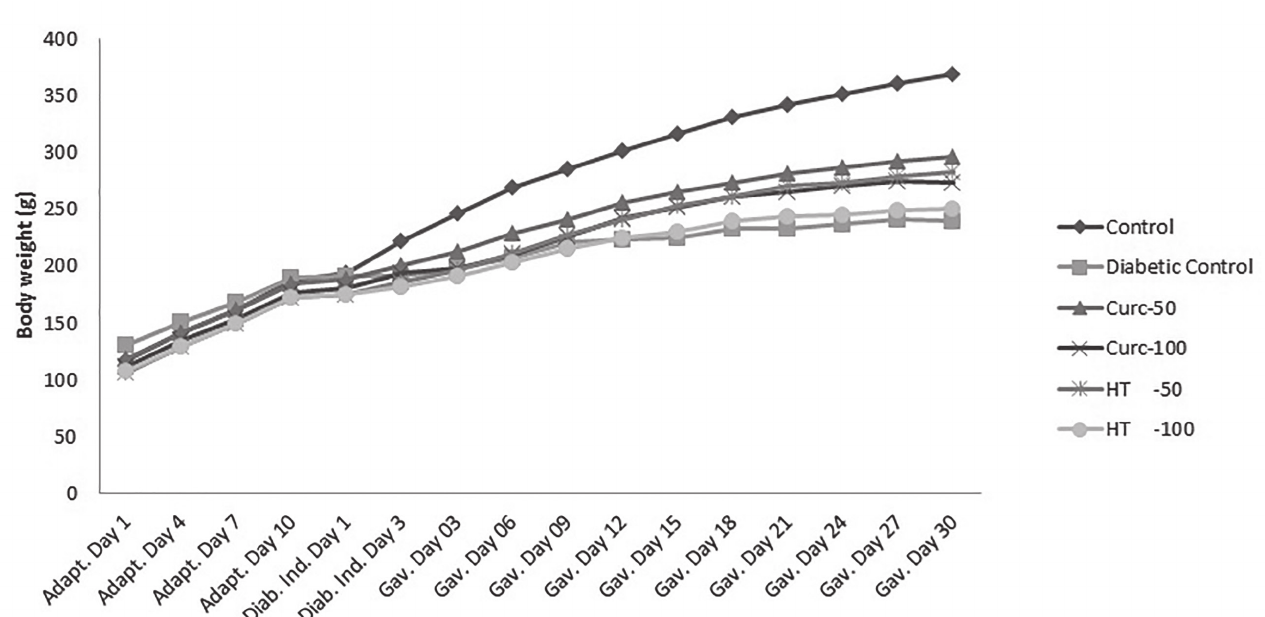
FIGURE 6 - Animals’ body weight evolution throughout experimental period. Adapt. = Adaptation period, measurement of body weight on the indicated days; Diab. Ind. = Diabetes induced period, measurement of body weight on the indicated days; Gav. = Oral gavage period, measurement of bodyweight on the indicated days. Control = control group,non-diabetic; Diabetic Control = diabetic control group, diabetic; Curc-50 = group Curc-50, diabetic, curcumin 50 mg/kg of body weight by oral gavage; Curc-100 = group Curc-100, diabetic, curcumin 100 mg/kg of body weight by oral gavage; HTNO -50 = group HTNO 50 mg/ - 50, diabetic, HTNO 2 2 2 kg of body weight by oral gavage; HTNO -100 = group HTNO -100, diabetic, HTNO 100 mg/kg of body weight by oral gavage. 2 2 2